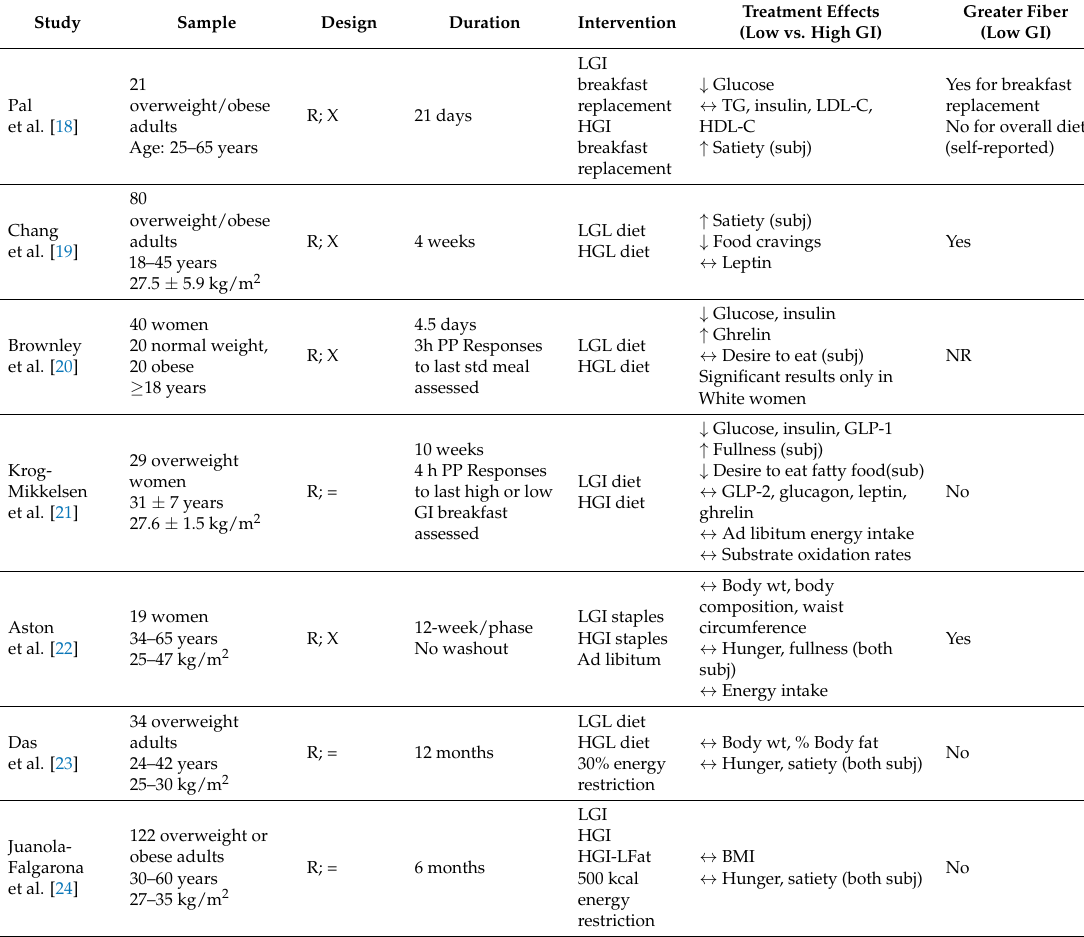
Table 2. Intervention studies assessing the effects of chronic intake of diets with different GI on appetite/satiety 1